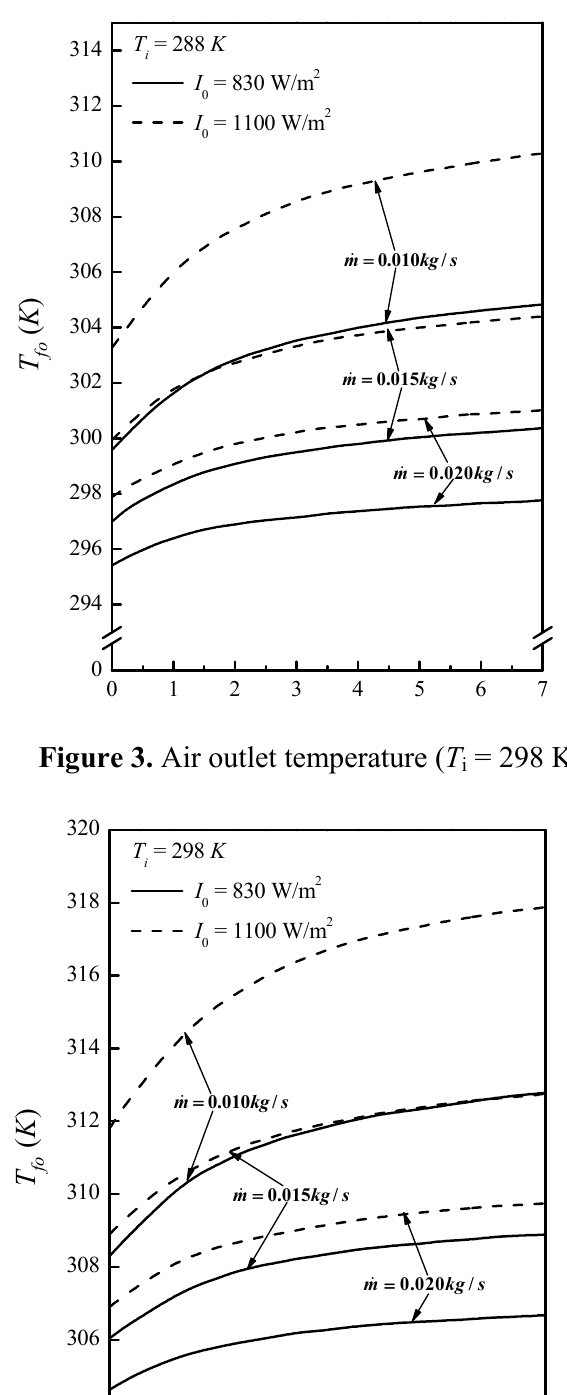
Figure 2. Air outlet temperature ( T